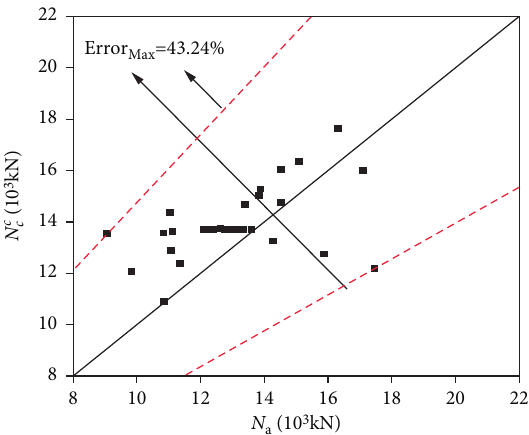
Figure 16: Comparison between N c